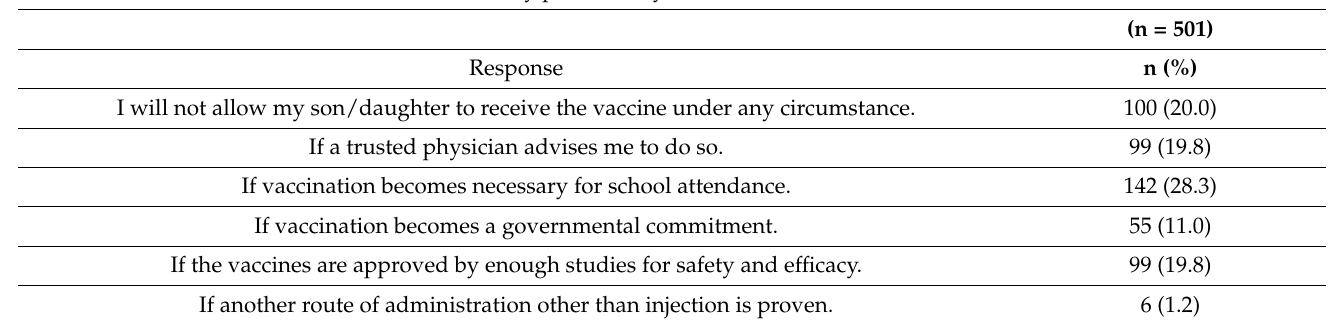
Table 2. Reasons for parents who did not intend to vaccinate their children and circumstances whereby they might allow them to receive a vaccine. Reasons for Non-Intentional Attitude n (%) Fear of the vaccine’s side effects. 342 (68.3) The vaccine has no protective value against the disease.